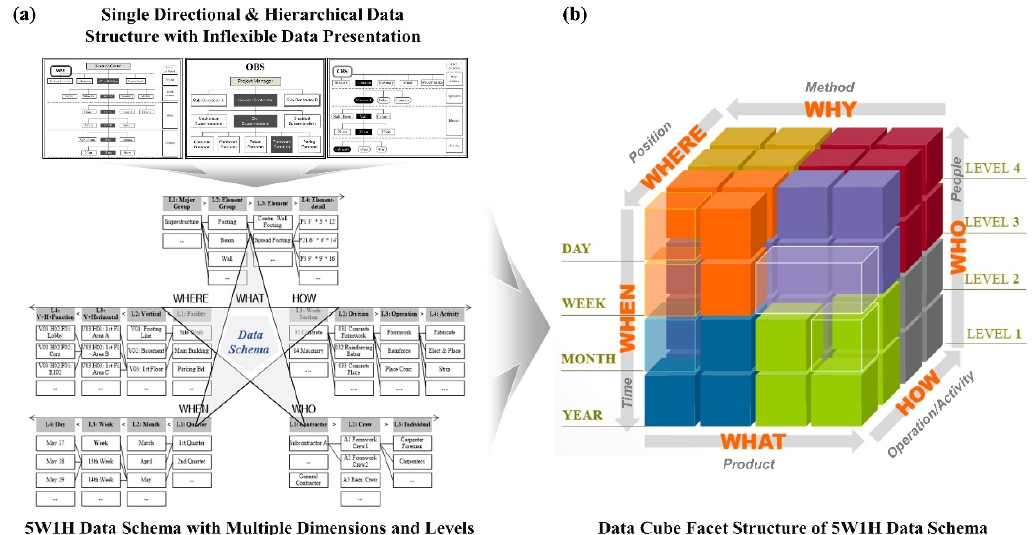
Figure 2. Data Framework for Integrated Cost-Schedule Management, ( a ) the 5W1H Data Schema (adopted from Cho et al. [4]), ( b ) Data Cube Facet Structure of the 5W1H Data Schema.